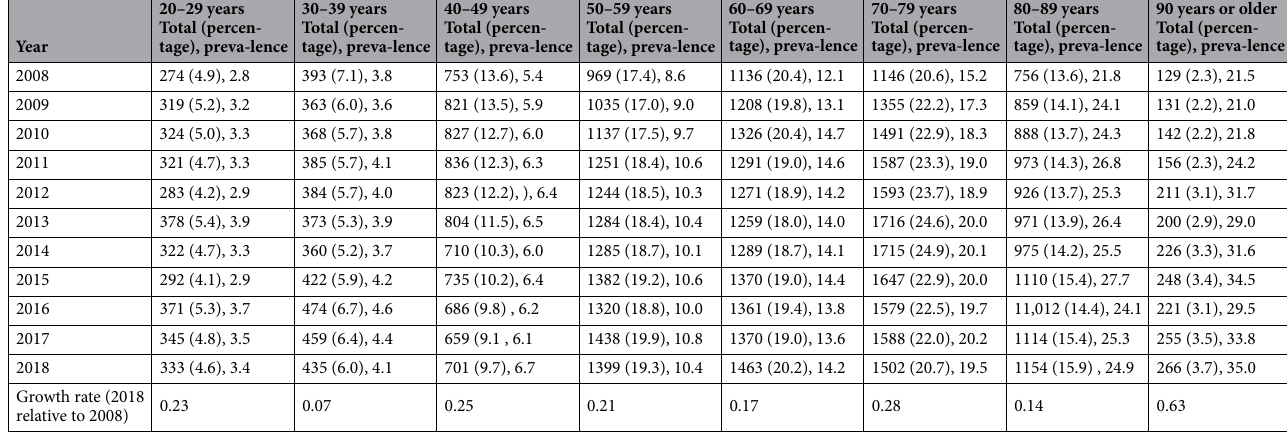
Table 4. Historic development from 2008 through 2018 of all fracture-related infection cases as a function of age group. Data is shown as total numbers, percentage and prevalence per 100,000 inhabitants of the considered age group.